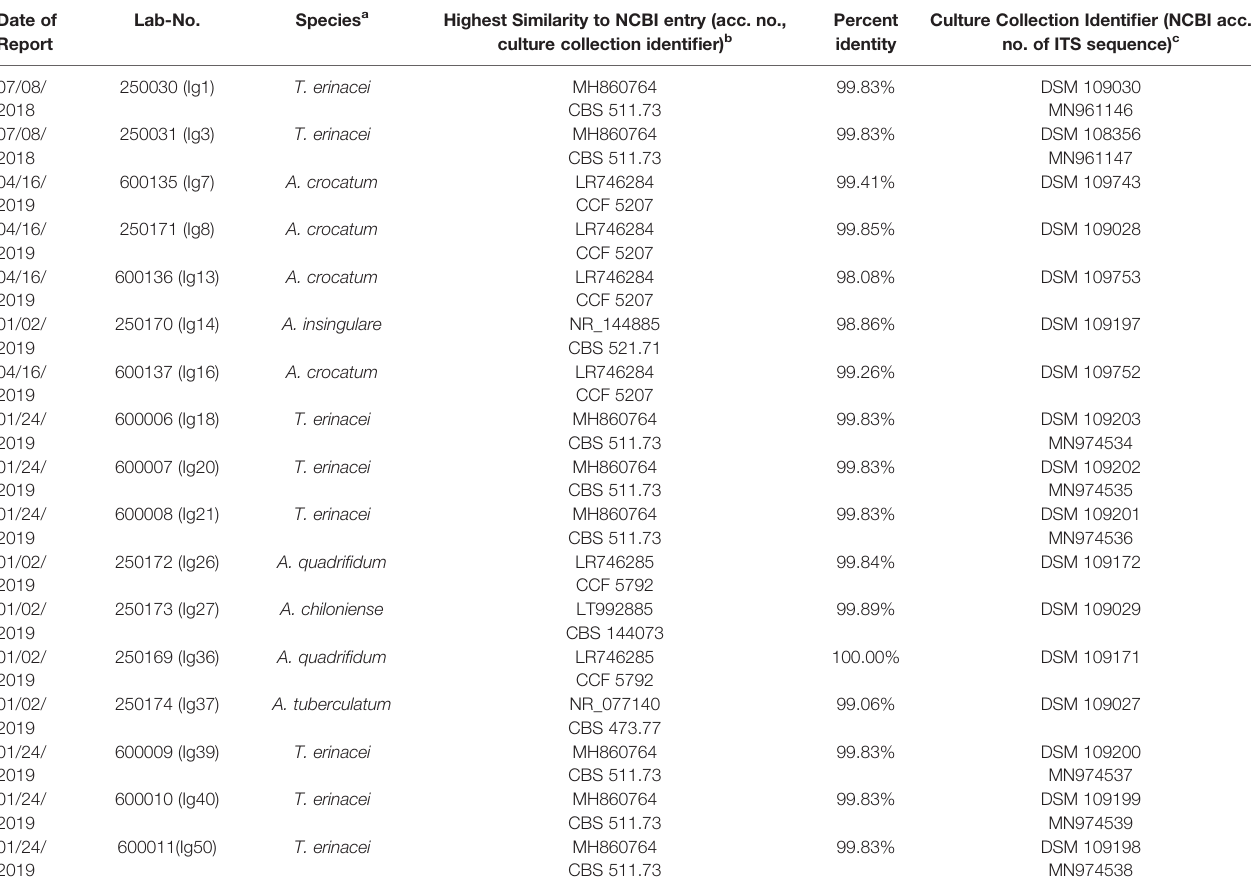
TABLE 1 | Identi fi cation of dermatophytes isolated from skin and spine samples of hedgehogs (Erinaceus europaeus) by PCR and sequencing of the internal transcribed spacer (ITS) region of fungal rDNA. Date of Report